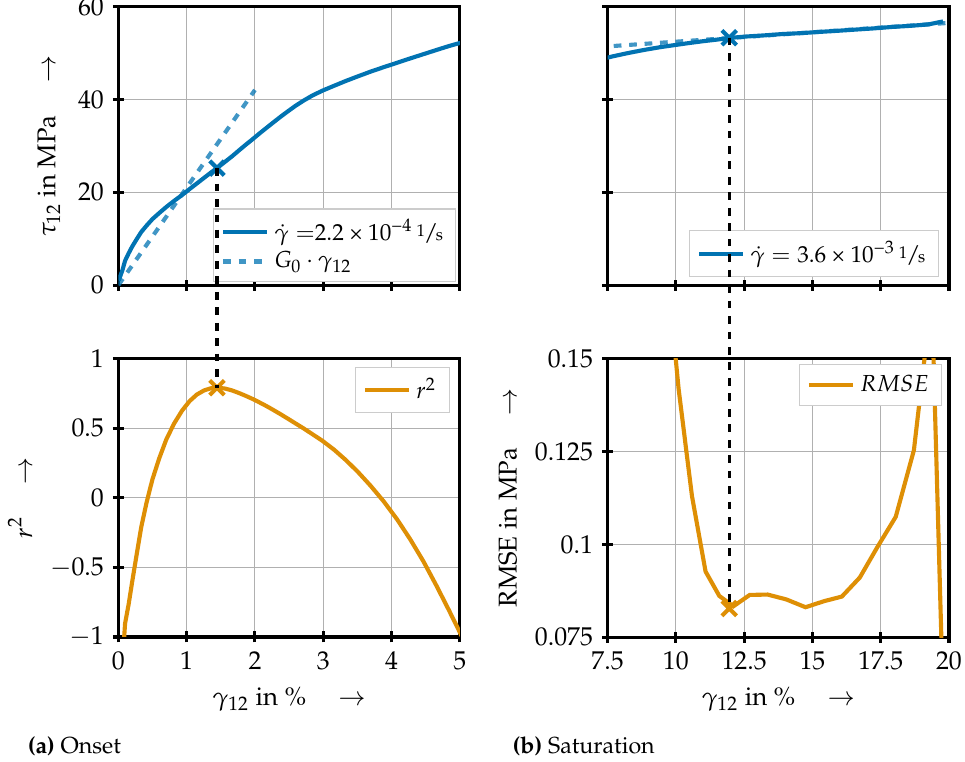
Figure 11. Comparison of models predicting onset and saturation of significant non-linearity for the